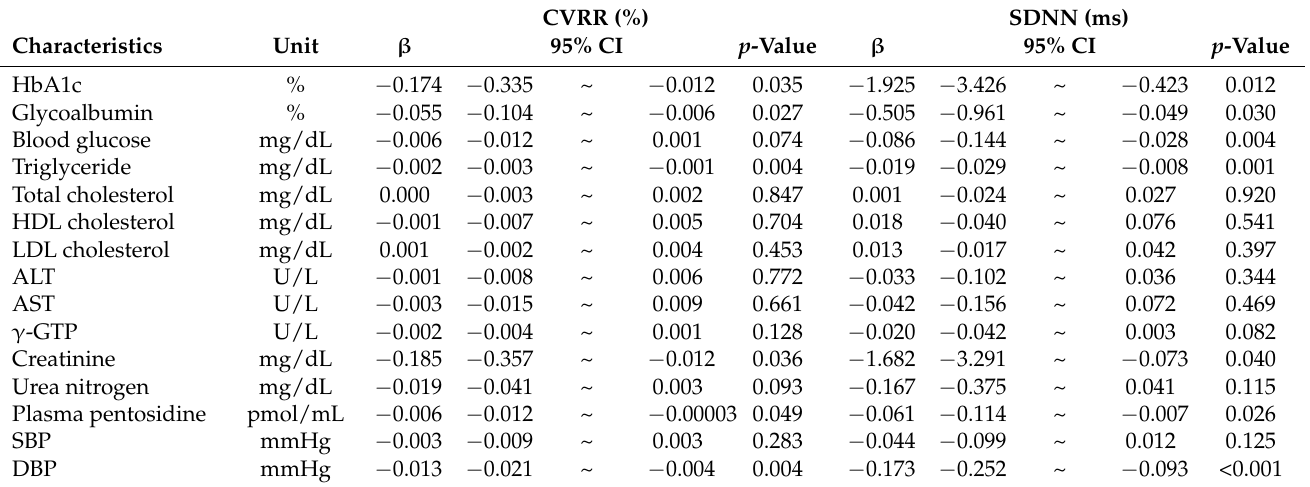
Table 3. Multivariate analysis of association with CVRR and SDNN (Model